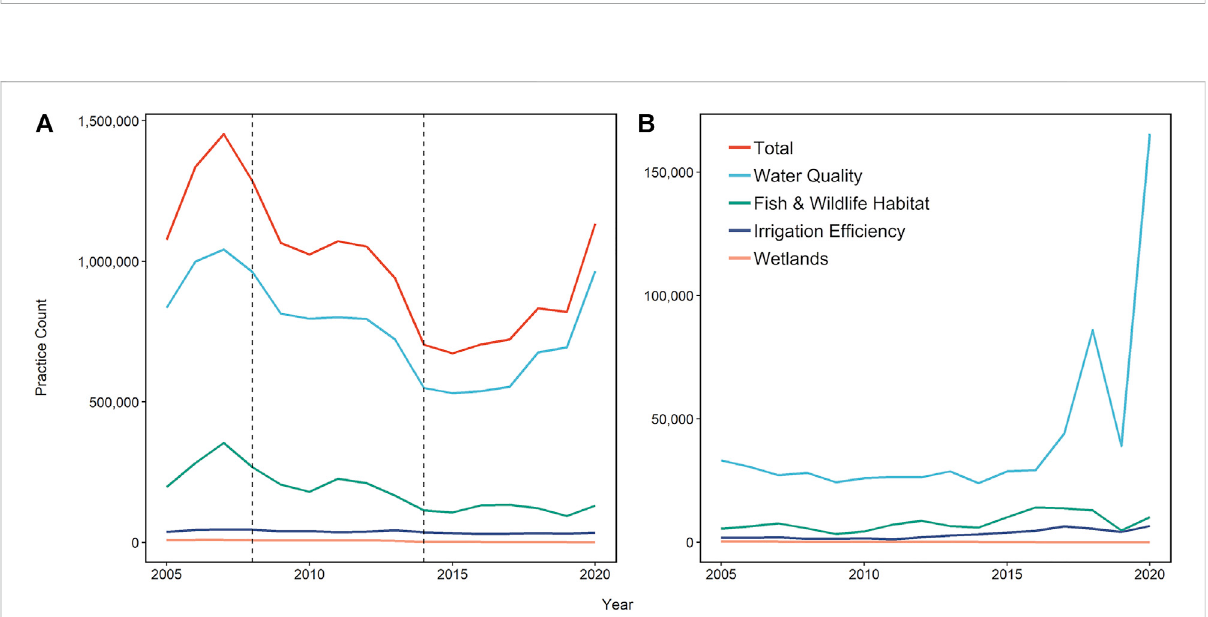
FIGURE 1 Changesinthenumberofconservationprojectsovertimein fi vemajorfreshwaterconservationprograms. (A) givesthenumberofprojectsper year in each program, normalized by the maximum number of projects observed in any year in that program. (B) gives the cumulative proportion of projects in each program over time. Program abbreviations match those in Table 1.